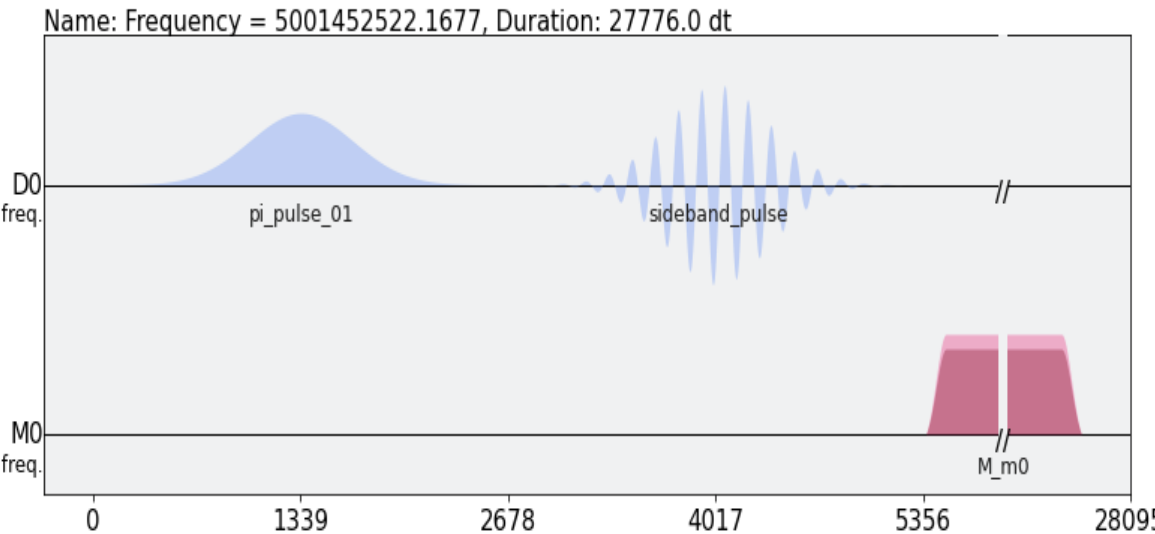
Figure 6. Signal measurement for the measured transitions. The first candidate extremum appears at ~4.6 GHz. It is to be noted that, as the level of the excited state grows, experiments may become less reliable and dependent upon the calibration status of the system. However, they can be used to depict that, in principle, higher-level energy states can be used to perform en- codings involving multiple logical quantum states. Concerning the error propagation, we can estimate that each transition required in- duces an error that is of the order of the error for the Pauli X Gate of the architecture. For the Armonk quantum computer, this is equal to 3.27 × 10 -4 A single logical qubit operation requires two such pulses, whereas the controlled operation requires only one. Assuming